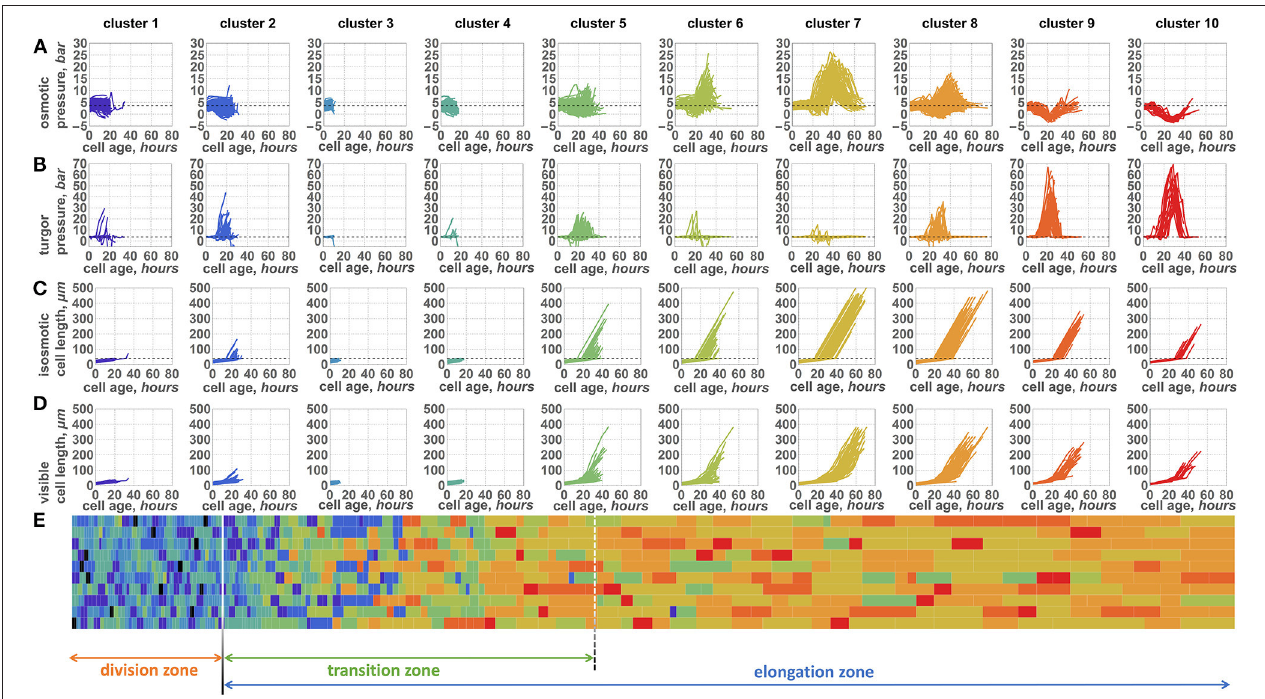
FIGURE 5 | Ten patterns of changes of internal parameters of the cells during symplastic growth. Plots of osmotic pressure (A) , turgor pressure (B) , isosmotic cell length (biomass) (C) , and visible length (D) (Y axis) with respect to the cell growing time (X axes, hours) are shown. Plot columns represent parameter changes for the cells from the representative clusters 1–10 (cluster numbers shown above the plot columns). Each cluster plot has a specific color. (E) 2D diagram of the epidermal cells at the time when the simulation stops. Cells are represented by the rectangles, whose sizes proportional to the cell sizes. The type of the cell (cluster to which cell belongs to) is shown by the same color as the cluster plot (see A–D ). The division of the leaf into zones is shown by arrows below the diagram.